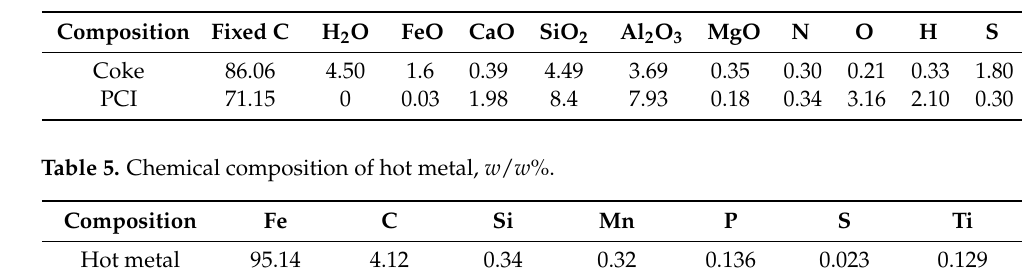
Table 4. Chemical composition of coke and pulverised coal, w / w %.